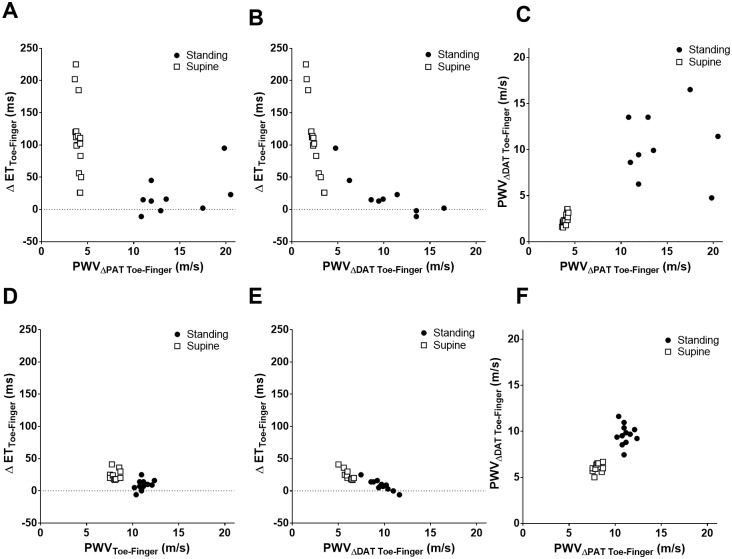
Relationship between ΔETToe-Finger, PWVΔPAT Toe-Finger, and PWVΔDAT Toe-Finger in individual subject.(A), (B), and (C) Measurements derived from a 23 year old female with the most compliant vasculature as evident by the lowest PWVΔPAT Toe-Finger in the supine position. (D), (E), and (F) Measurements derived from a 36 year old female with the least compliant vasculature as evident by the highest PWVΔPAT Toe-Finger in the supine position. Each dot on the graph was derived from a single heartbeat in the standing (black circles) and supine (white squares) position. (A) and (D) Scatter plot of ΔETToe-Finger and PWVΔPAT Toe-Finger. (B) and (E) Scatter plot of ΔETToe-Finger and PWVΔDAT Toe-Finger. (C) and (F) Scatter plot of PWVΔDAT Toe-Finger and PWVΔPAT Toe-Finger. ET: ejection time; PWV: pulse wave velocity; PAT: pulse arrival time; DAT: dicrotic notch arrival time.